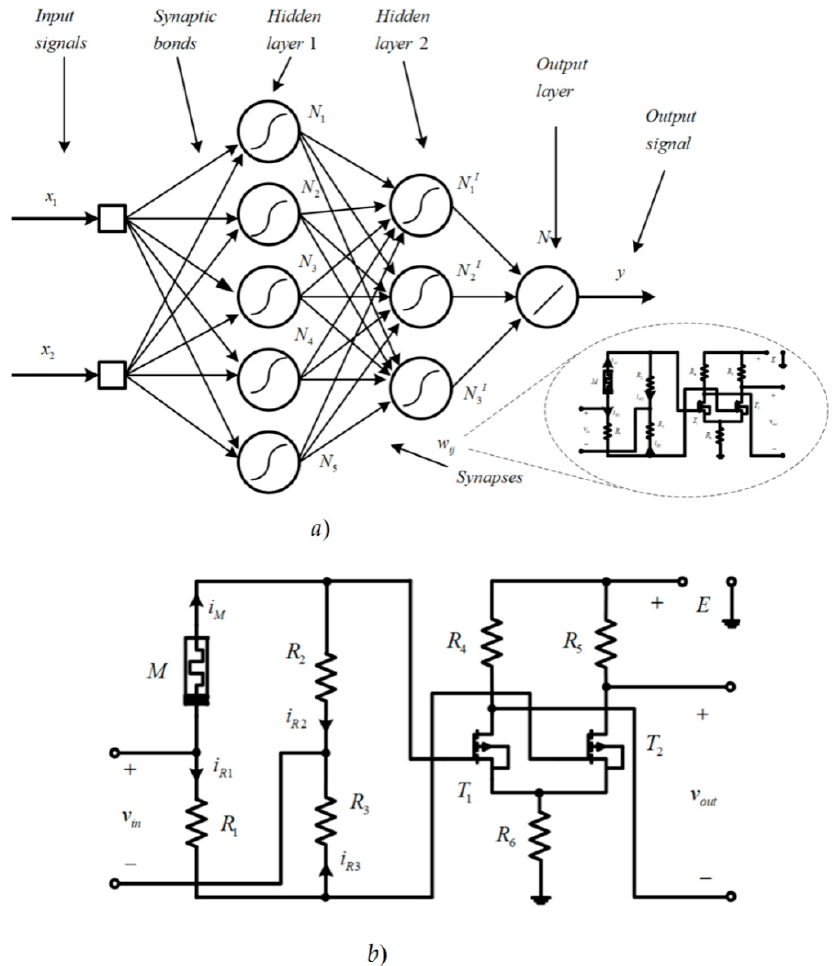
Figure 10. ( a ) Structure of a memristor neural network; ( b ) A schematic of a memristor-based syn-